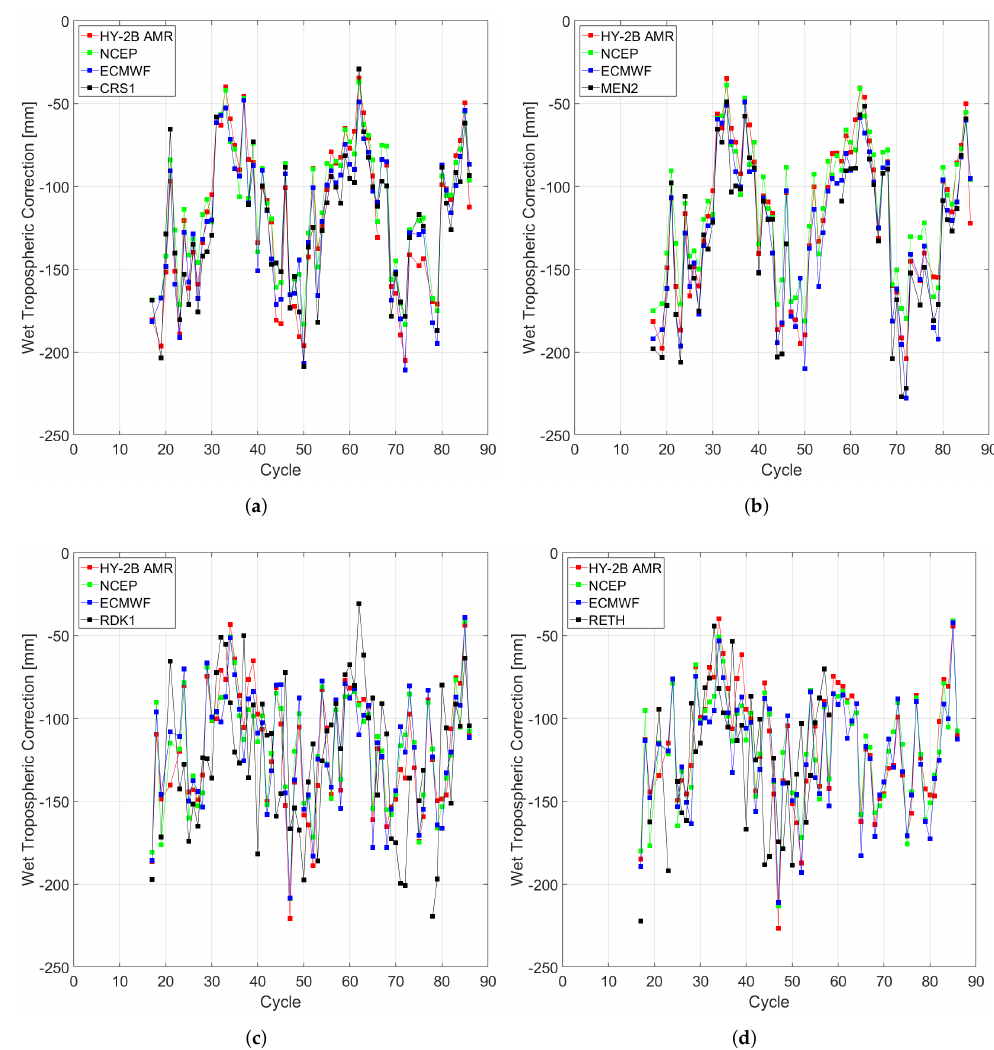
Figure 17. Fitted HY-2B AMR and model-derived wet tropospheric corrections at ( a ) CRS1, ( b ) MEN2, ( c ) RDK1 and ( d ) RETH points of closest approach. The HY-2B AMR fitted values correspond to Pass 66 (top) and 161